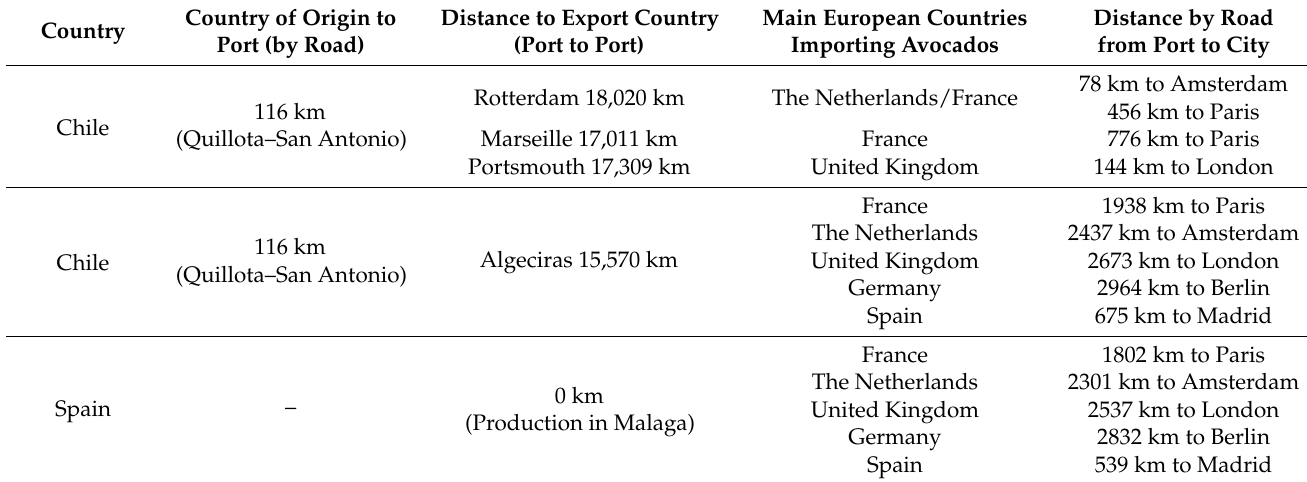
Table 1. Distances used for the LCA calculation of the impacts of transportation of 1 kg of avocado cv. Hass fruit exported via different